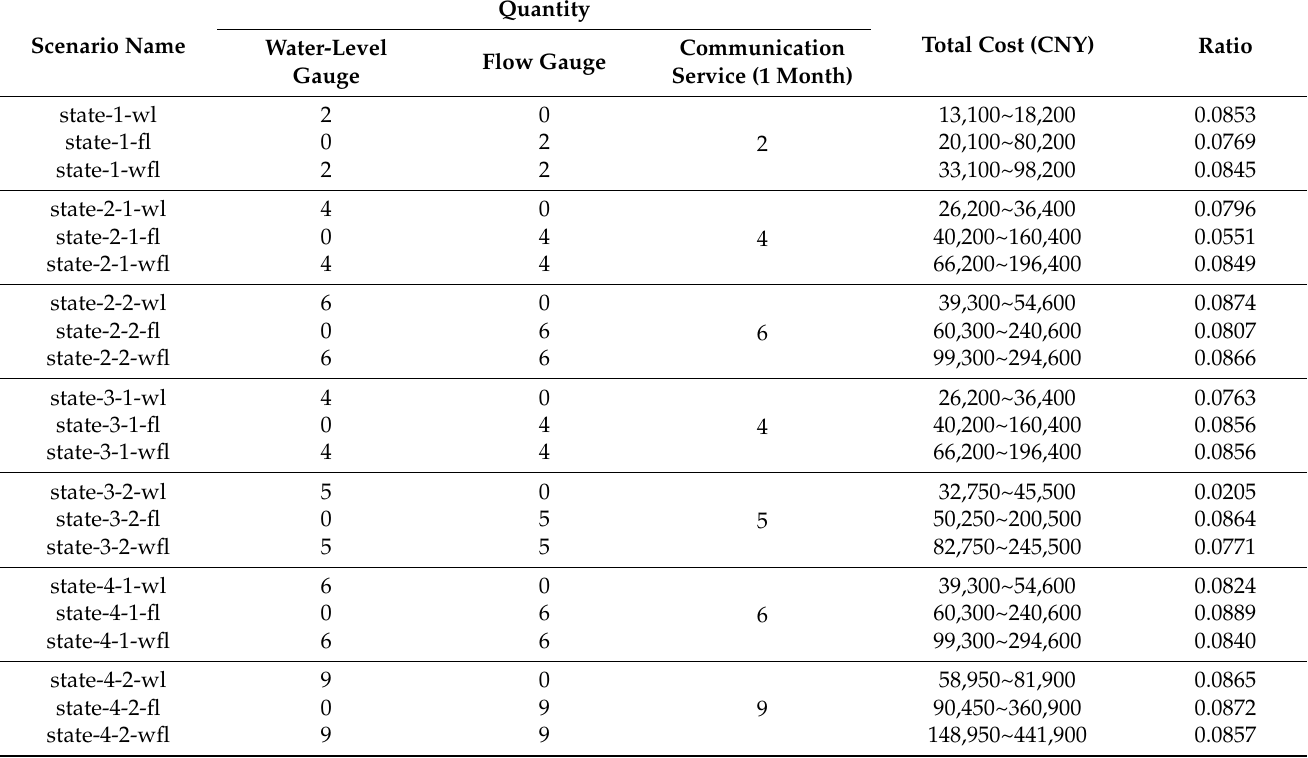
Table 8. Cost-effective analysis of different